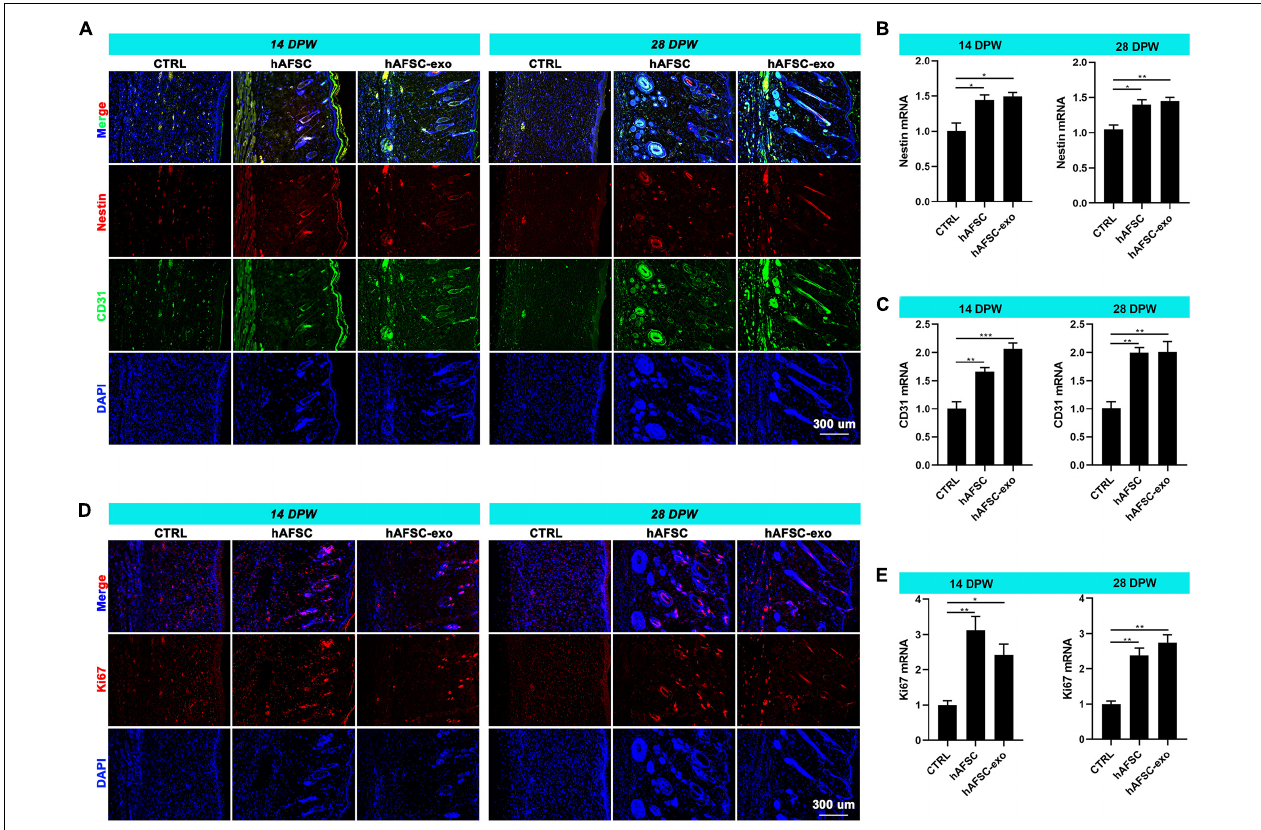
FIGURE 3 | hAFSC-exo promotes the regeneration of nerves and vessels during wound healing in rats. (A–C) IF staining and qRT-PCR analysis of Nestin (nerve) and CD31 (vessel) in the healed tissues. (D,E) IF staining and qRT-PCR analysis of Ki67 in the healed tissues. Scale bar = 300 µ m; * P < 0.05; ** P < 0.01; *** P < 0.001; mean ± SD; n = 5. DAPI, 4 (cid:48) ,6-Diamidino-2-phenylindole; IF,